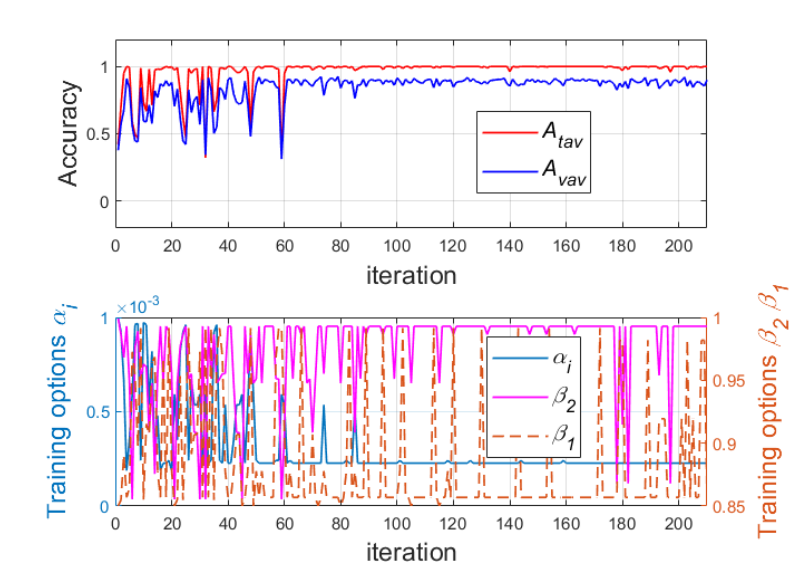
Figure 8. Changes of average values of training A tav and verification A vav accuracies and the initial learning rate α i , squared gradient decay rate β 2 and gradient decay rate β 1 of the Adam during the first 80 iterations of